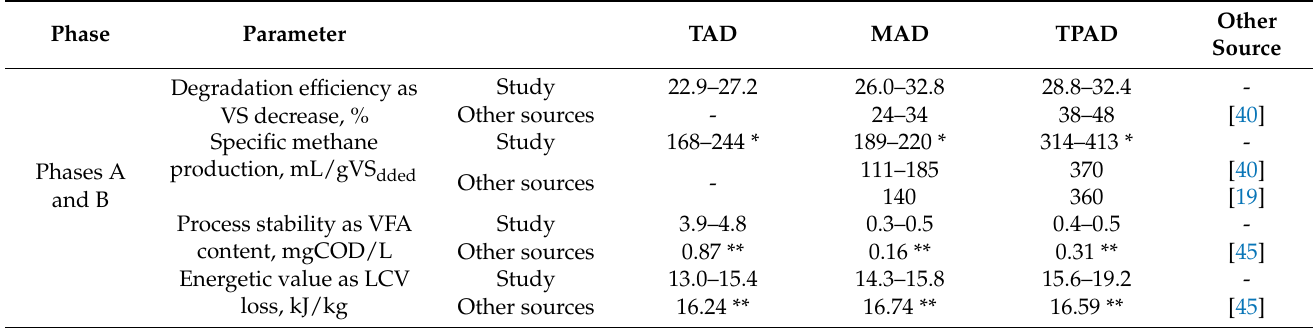
Table 14. Comparison of TAD, MAD and TPAD results with other